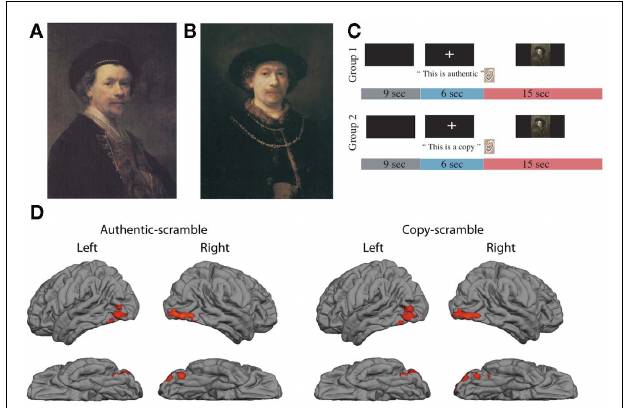
FIGURE 1 | (A) Sample of genuine Rembrandt portrait (REAL); (B) derivative portrait in the style of Rembrandt (FAKE); (C) sequence of auditory cues and image presentation; (D) brain activations in occipital and temporal cortex generated by presentation of portraits after subtraction of activations generated by scrambled images of portraits; data averaged across 14 participants, red regions show significant BOLD activations during period of image presentation ( Z > 2.3, p < 0.05, corrected for multiple